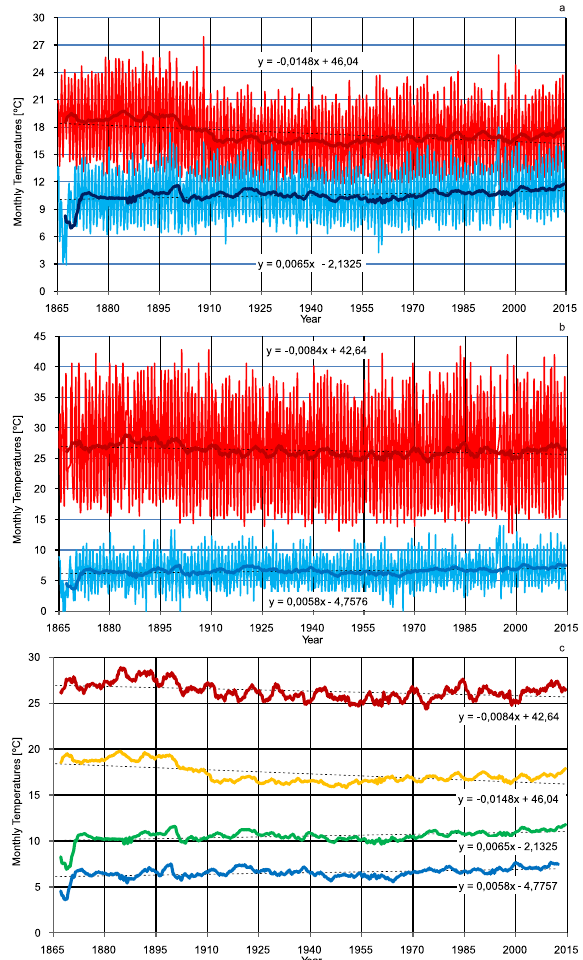
Fig. 1. Temperatures in Cape Otway Lighthouse: a) monthly values of average maximum and average minimum with 36 months average and linear trends; b) monthly highest and lowest values with 36 months average and linear trends; c) 36 months average and linear trends of monthly average maximum and minimum, highest and lowest. Data from